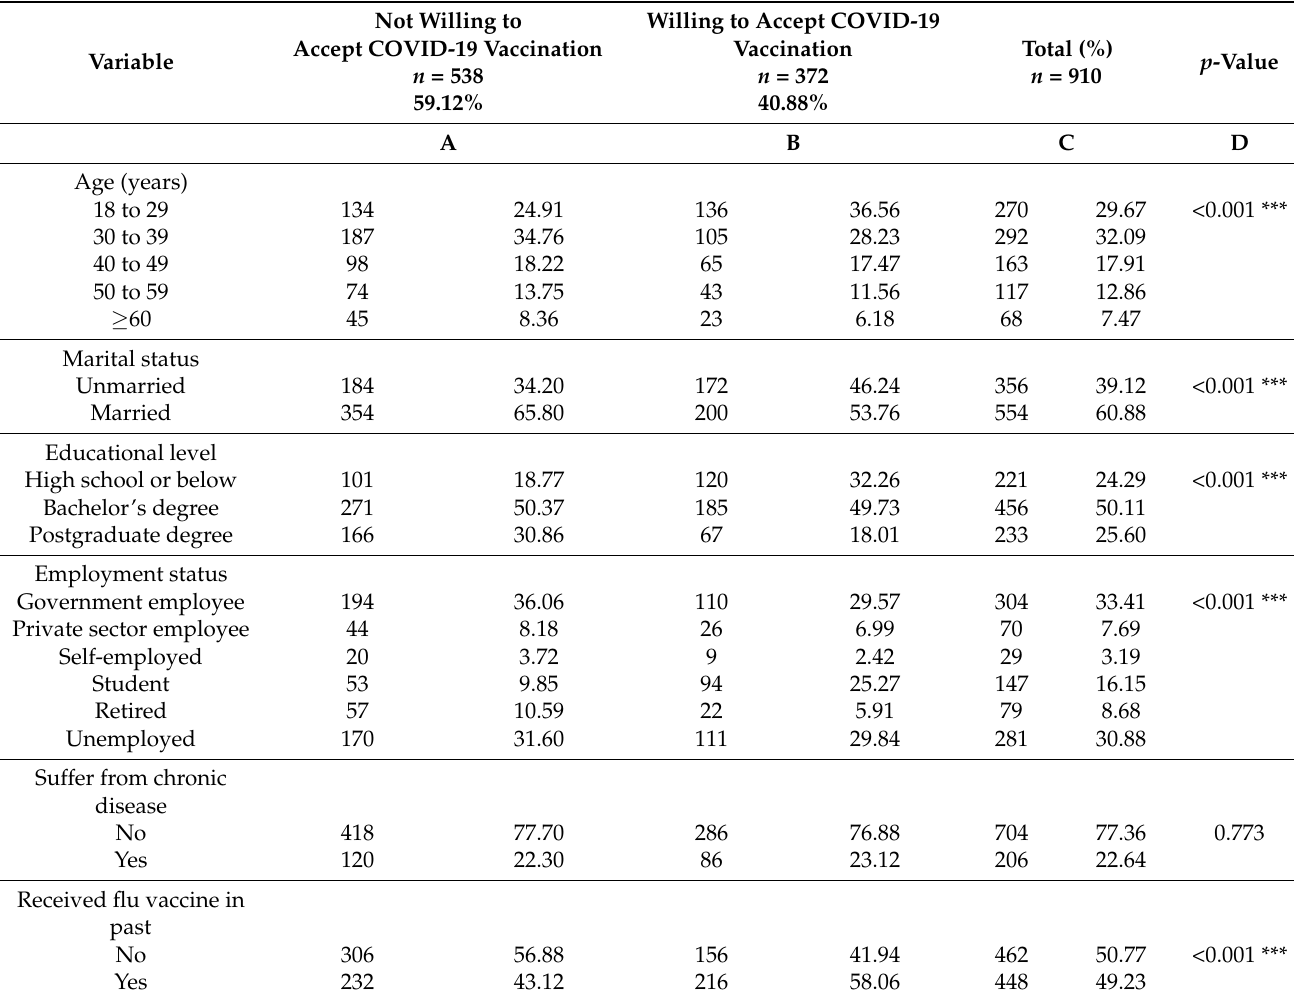
Table 1. Frequency distribution and chi-squared analysis of acceptance of COVID-19 vaccination among women ( n =